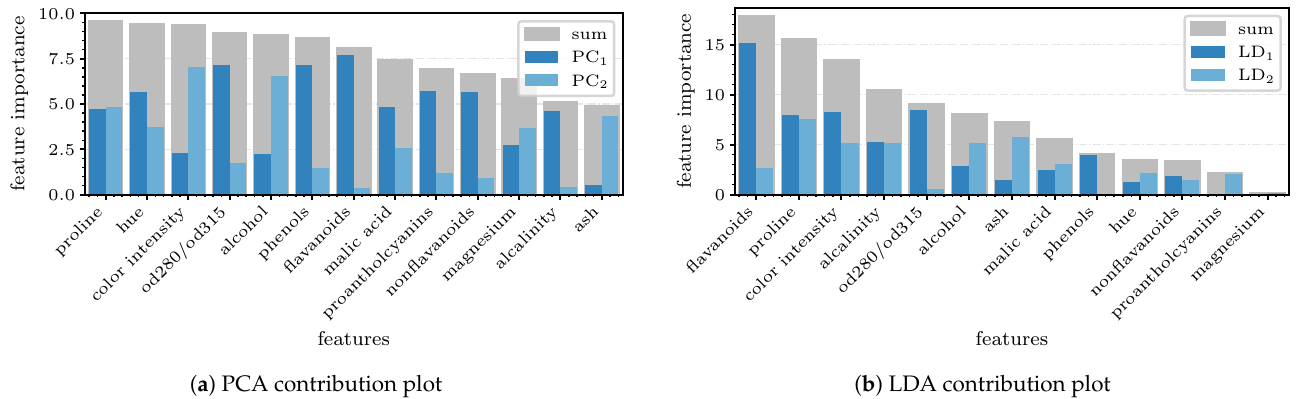
Figure 8. Contribution plots for the first two components of the Wine Classification dataset. The bar heights for the PCs ( a ) and linear discriminants (LDs) ( b ) do not represent the contribution in percent, but the proportion of the sum. In a descending manner, the most important features are displayed on the left side of the